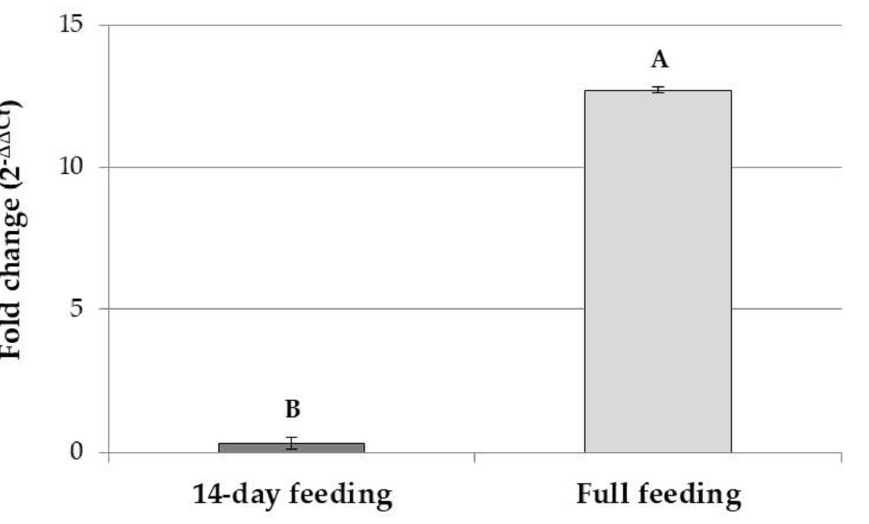
Figure 2. Gene expression (2 − ∆∆ Ct ) of Tenecin 3 in T. molitor larvae reared on +GRAIN after a 14-day feeding period or in mature larvae eclosed directly on +GRAIN and collected when the first two pupae were observed in the rearing. Values are reported as average fold change variation (mean ± SE). Samples were normalized against larvae reared on BRAN for their respective timescales. Different letters indicate significantly different values (Student’s t -test, p < 0.05).